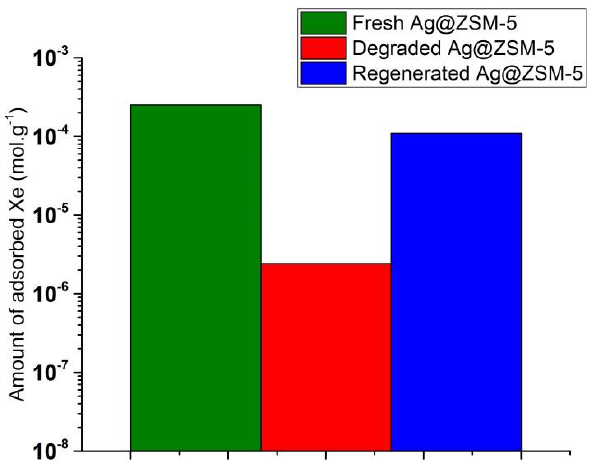
Figure 6. Xenon adsorption capacity at 5 ppm for the fresh ( green ), degraded ( red ), and regenerated ( blue ) Ag@ZSM-5. Plot is indicated in a log scale.